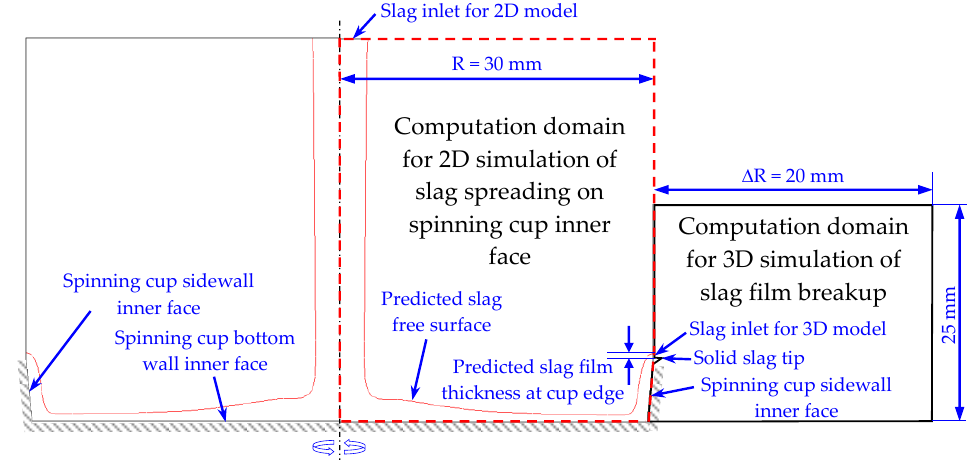
Figure 1. Two-dimensional schematic illustration of computation domains defined in 2D and 3D CFD models.